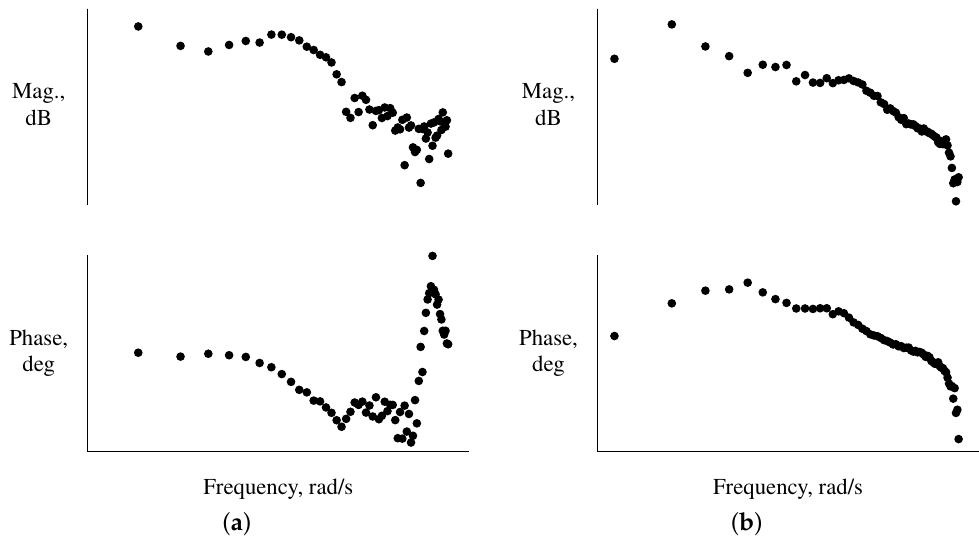
Figure 6. The simultaneous estimation of X-56A broken loops from flight test data: ( a ) elevator loop; ( b ) forward pitch rate gyroscope